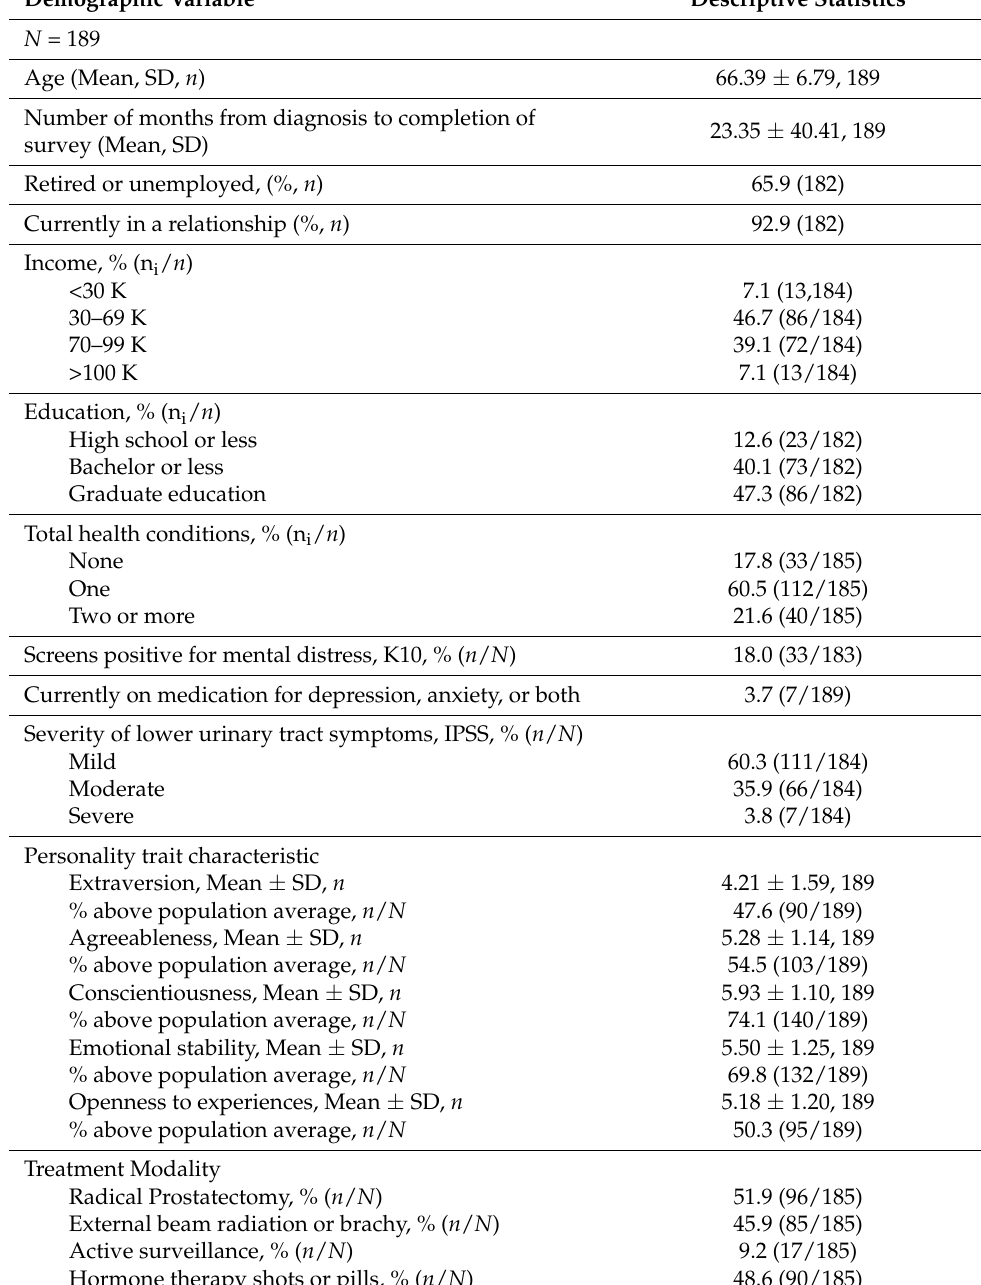
Table 1. Demographic characteristics of a sample of men with a history of prostate cancer diagnosis from the baseline cycle of the Soillse Prostate Cancer Quality of Life Maritimes Survey (2017–2019), n =